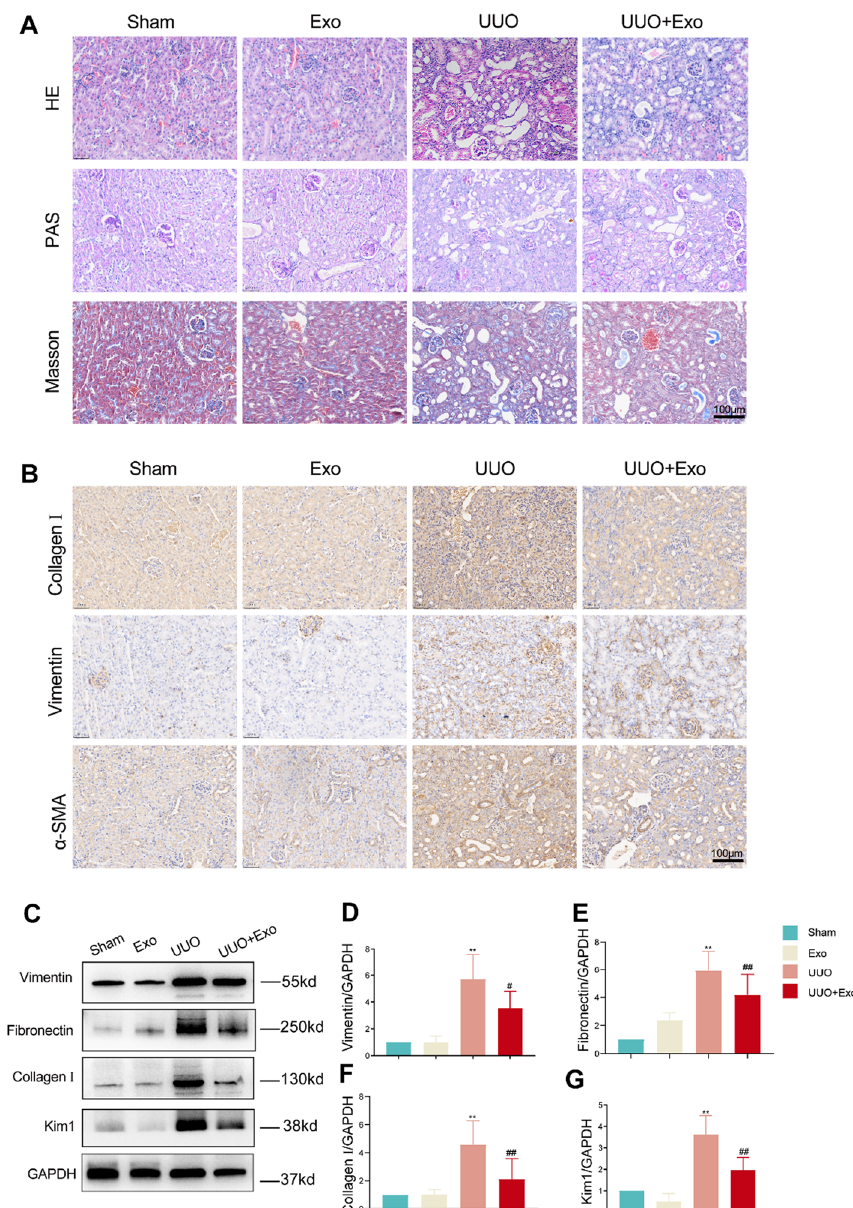
Fig. 2 Examination of kidney morphology and fibrosis markers in four groups in vivo. A HE, PAS, and Masson staining in each group. B Immunohistochemistry of fibrosis-related markers (Collagen I, Vimentin, and α-SMA) in each group. C Western blot of fibrosis-related markers (Collagen I, Vimentin, and α-SMA) and Kim1 in each group. D – G Relative expression of fibrosis-related markers and Kim1 detected by western blot. * p < 0.05, ** p < 0.01, compared with sham group; # p < 0.05, ## p < 0.01, compared with UUO